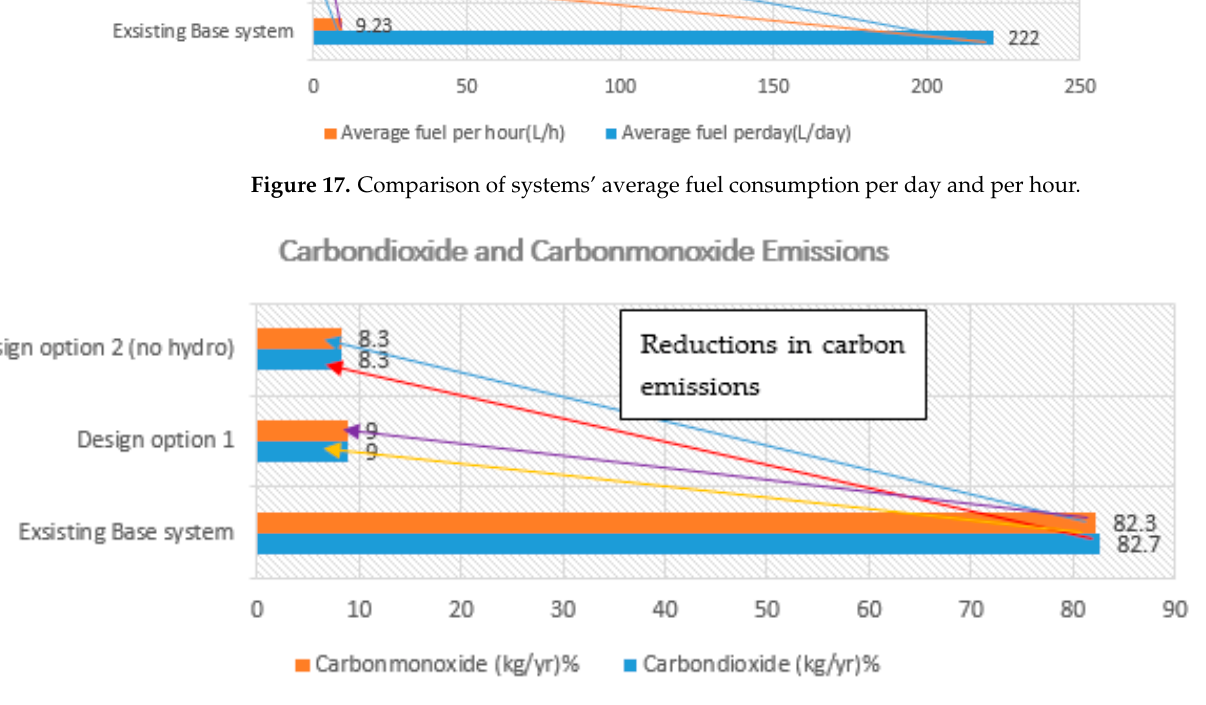
Figure 18. Carbon dioxide and Carbon monoxide emissions.